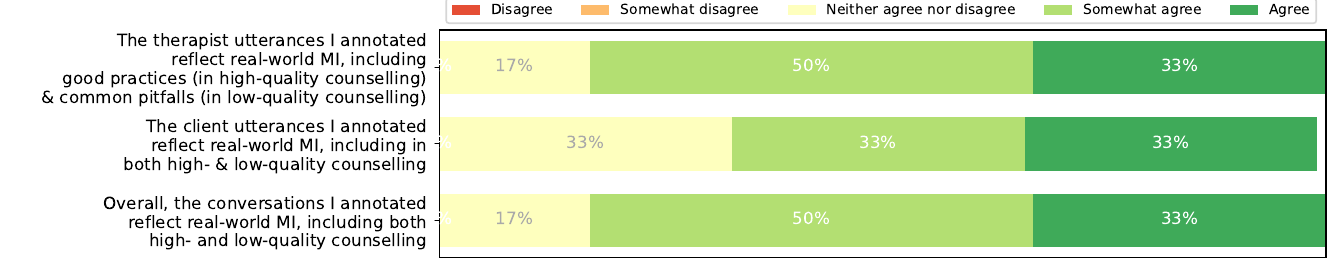
Figure 2. Results of survey of annotators regarding whether AnnoMI reflects real-world high- and low-quality